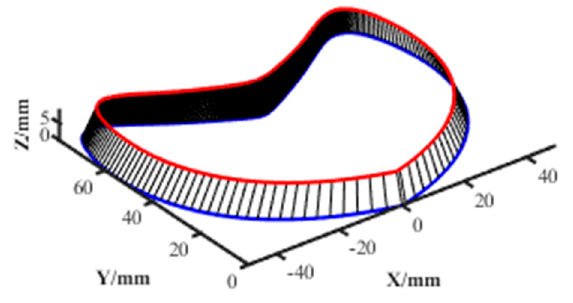
Figure 7. The cardioid curve and tool orientation vector.